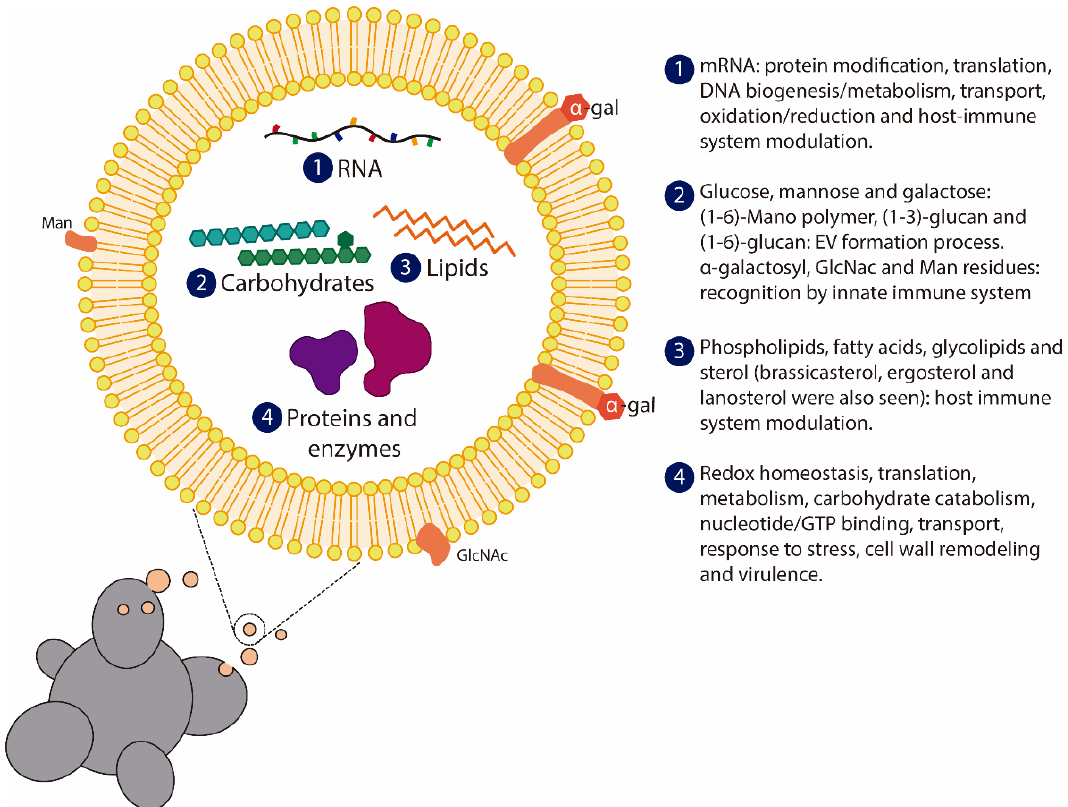
Figure 4. Representation of Paracoccidioides spp. extracellular vesicles (EV). Several studies regarding proteomics, lipidomics, transcriptomics, and general EVs composition were performed in order to characterize Paracoccidioides spp. EVs composition and content. The secretory pathway can occur by conventional and unconventional release, however these mechanisms are not yet fully characterized in Paracoccidioides spp. The content and composition of EVs are distributed among ( 1 ) RNA (mRNAs, non-coding RNAs, small RNAs, and interference-RNAs); ( 2 ) carbohydrates (glucose, mannose, and galactose), including N-Acetylglucosamine (GlcNAc) and mannan residues in EVs surface; ( 3 ) lipids (brassicasterol, ergosterol and lanosterol); and ( 4 ) proteins and enzymes involved with a myriad of signaling pathways and host immune system modulation.